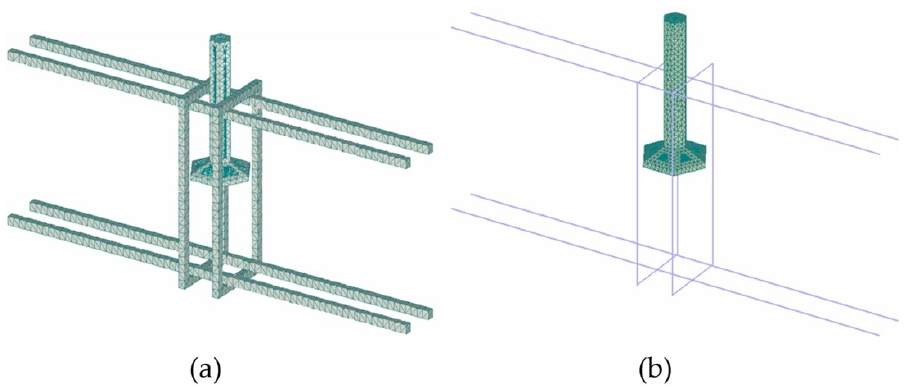
Figure 10. Different ways of modelling supplementary reinforcement: ( a ) 3D solid elements; ( b ) 1D elements.